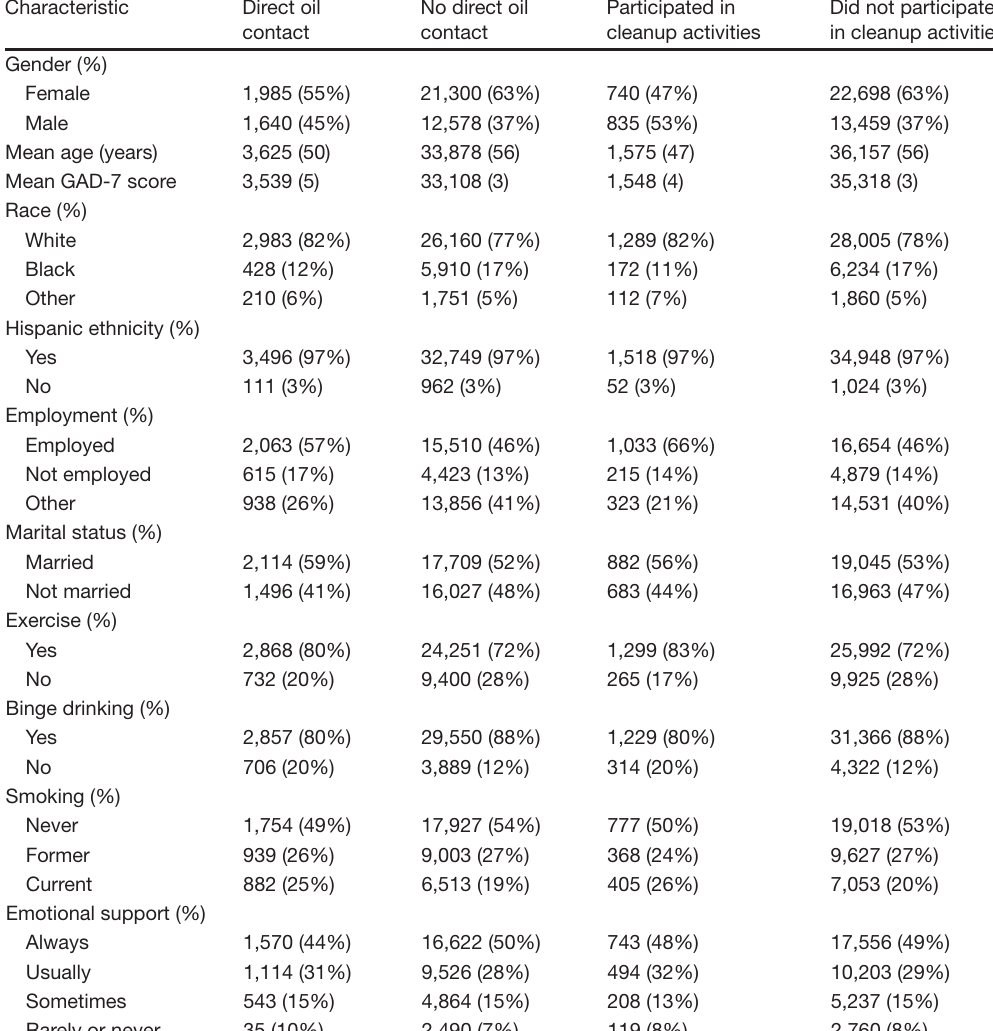
Table 2. Characteristics of the sample stratified by direct oil contact and participation in cleanup activities during the Deepwater Horizon oil spill. The numbers in rows that show (%) are N and percent, the numbers without (%) are mean and SD